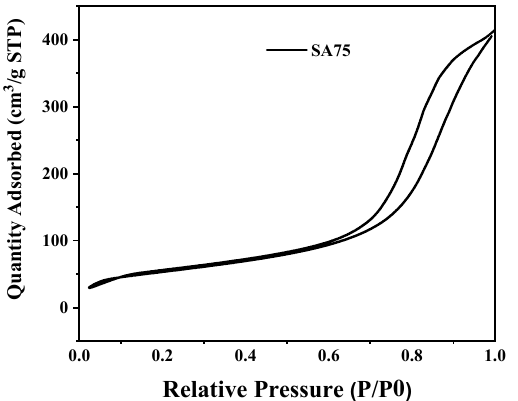
Figure 1. N 2 adsorption–desorption measurements of fresh Ni-supported catalysts. 2.2. TPR H 2 -TPR (temperature-programmed reduction) curves of the fresh catalysts are shown in Figure 2. In the range of 0–330 °C, peaks did not appear, indicating that there was no free NiO in the samples. Practically, all the samples were characterized by a single broad peak. The peaks for SA39 at 368 °C, SA35 at 460 °C, and SA02 at 470 °C could be attributed to moderate interactions between NiO and the support. Comparatively, the peak for SA32 at 671 °C could be ascribed to the strong interaction between NiO and the support. Meanwhile, the peak at 825 °C for SA75 could be related to the formation of NiAl 2 O 4 , which was caused by the strong interaction of Al 2 O 3 with NiO [22] .